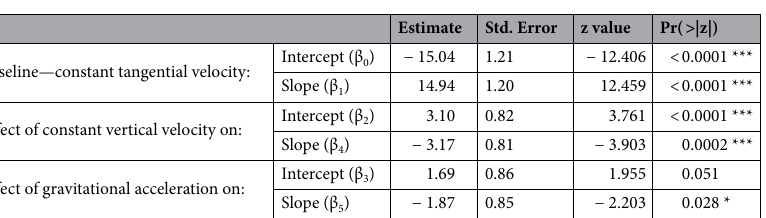
Table 2. All coefficients of the GLMM for the fixed factors in the model used to fit the probability of ‘longer’ responses for 15 participants and the relative P value are shown (Baseline: constant tangential velocity).*P < 0.05. **P < 0.01. ***P < 0.001.